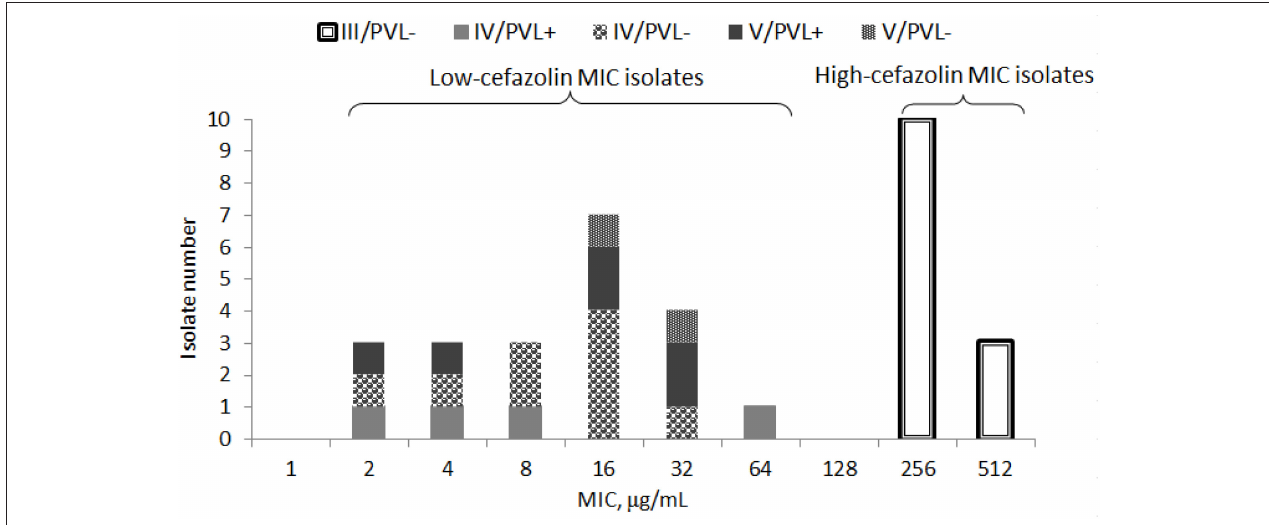
FIGURE 1 | Minimal inhibitory concentration (MIC) distribution of cefazolin in 34 isolates of methicillin-resistant Staphylococcus aureus stratified by SCC mec types (III, IV, or V) with or without Panton-Valentine leucocidin (PVL + or PVL − ).